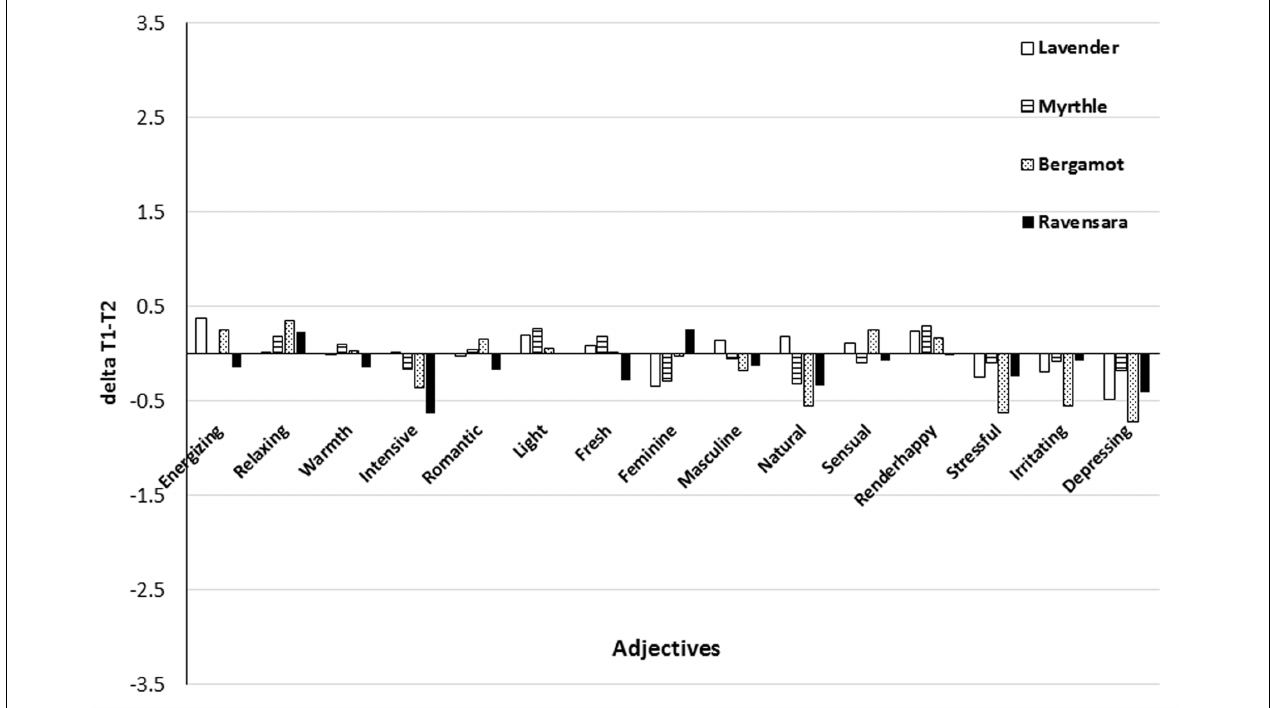
FIGURE 3 | Mean differences in adjective values between T2 and T1 (Delta T1–T2) for each